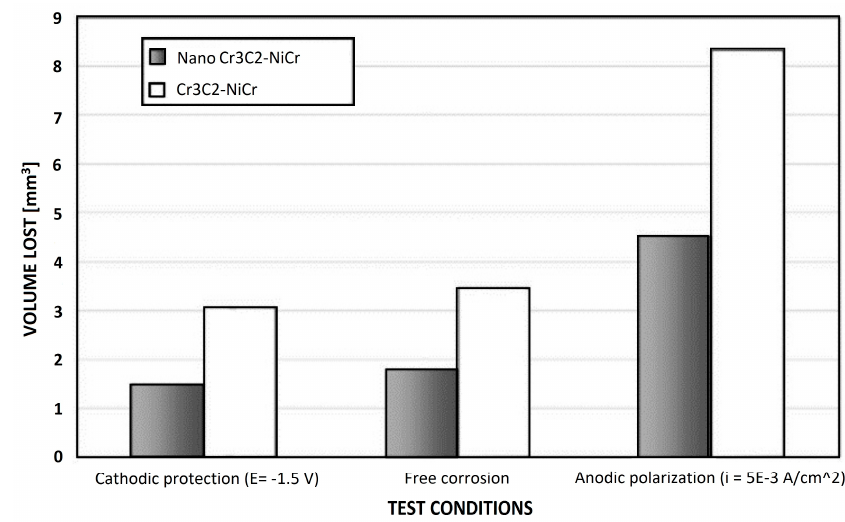
Figure 6. Volume loss of the high-velocity oxy-fuel (HVOF) coatings under the different tribo-corrosion conditions [6]. Reprinted with permission from ref [6]. © 2004 Elsevier.